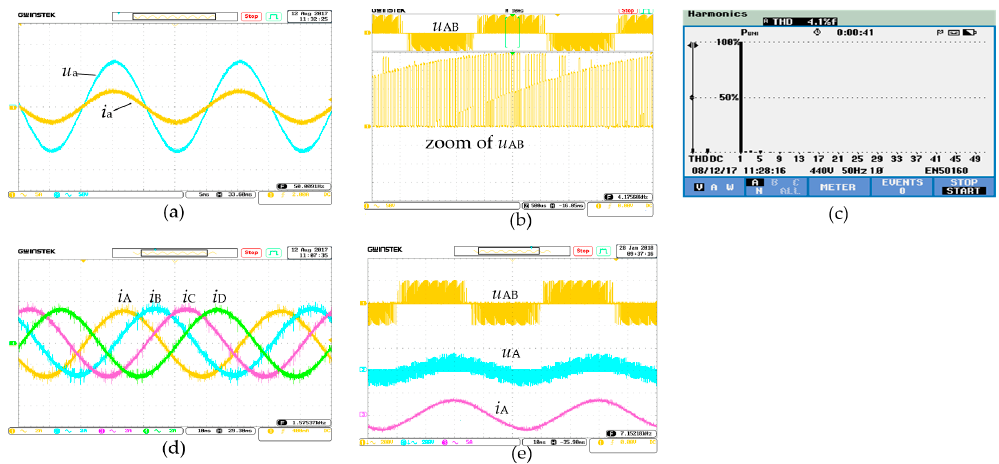
Figure 7. Experimental waveforms with U in = 80 Vrms, f out = 20 Hz, and q = 0.6: ( a ) input voltage u a and input current i a ; ( b ) output line ‐ to ‐ line voltage u AB and zoom of u AB ; ( c ) the FFT analysis of the u AB ; ( d ) output currents i A , i B , i C , i D ; ( e ) output line ‐ to ‐ line voltage u AB , output phase voltage u A , and the output phase current i A